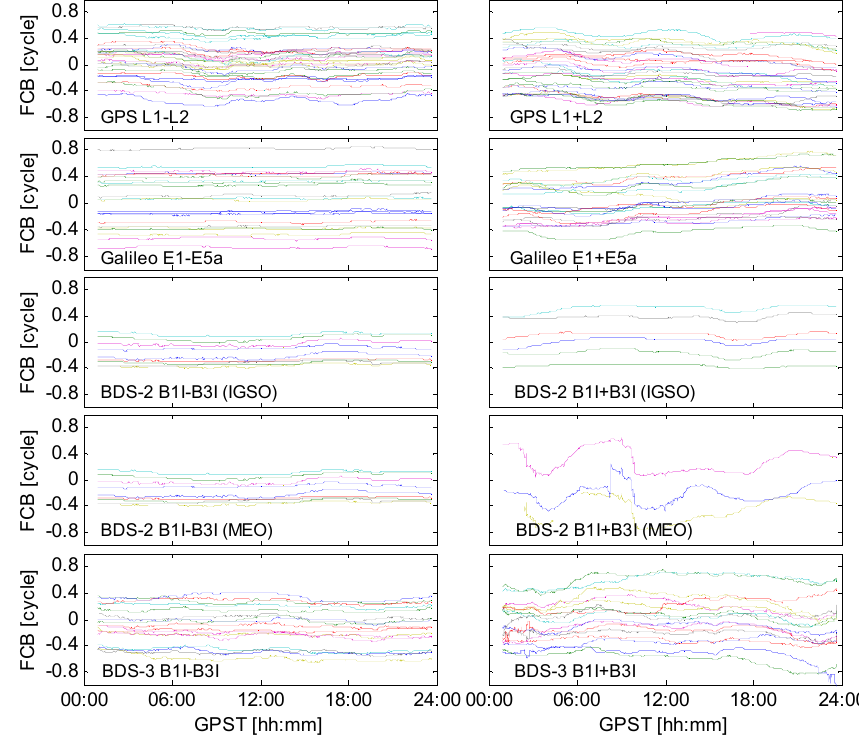
Figure 4. Daily EWL FCB series of GPS/Galileo/BDS-2/BDS-3 (2020 DOY148). FCB of each system generally did not exceed 0.1 cycles. Table 3. Daily STD statistical results of GPS/Galileo/BDS-2/BDS-3 EWL FCB.